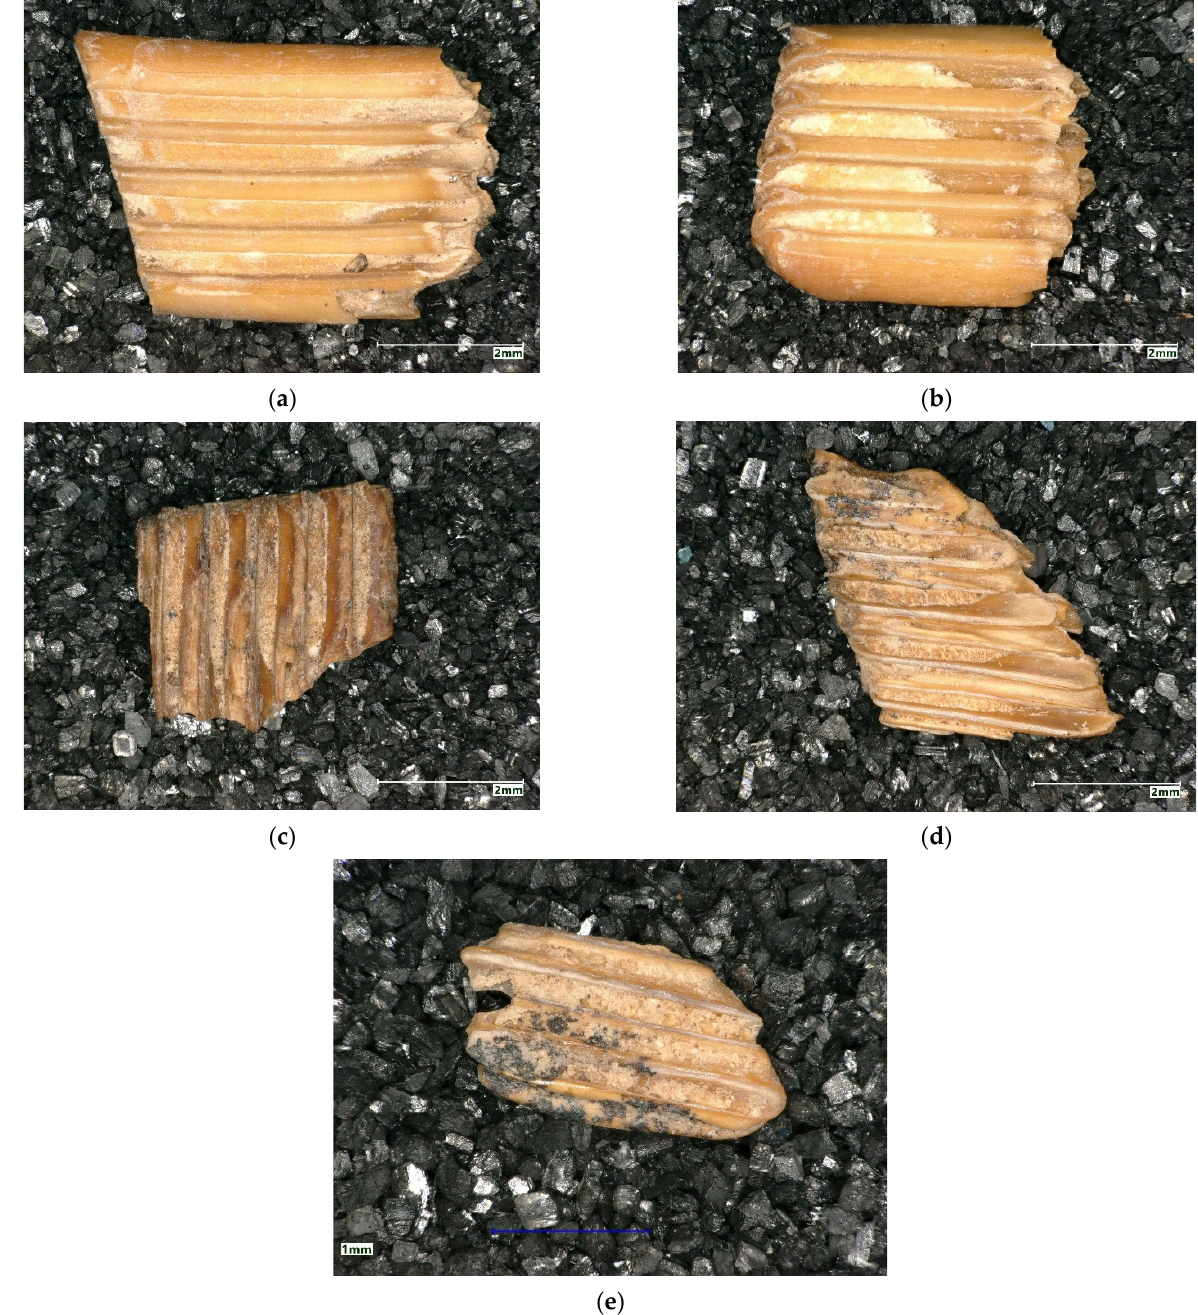
Figure 5. Arvicoline molars from the Shanidar Cave assemblage displaying the different categories of digestion intensity: ( a ) Molar displaying no digestion marks. ( b ) Molar displaying light digestion marks. ( c ) Molar displaying moderate digestion marks. ( d ) Molar displaying heavy digestion marks. ( e ) Molar displaying extreme digestion marks. Note the manganese staining in Figure 5d,e. A breakdown of the overall assemblage molar digestion data is shown in Table 6.